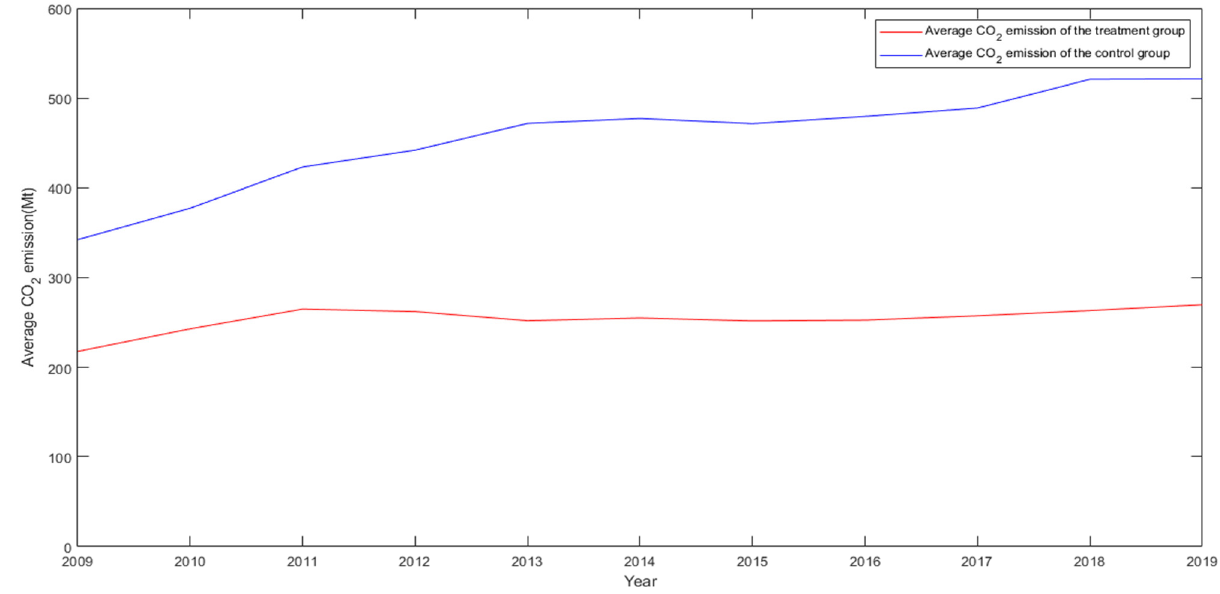
Figure 1. Trend of average CO 2 emissions from 2009 to 2019.